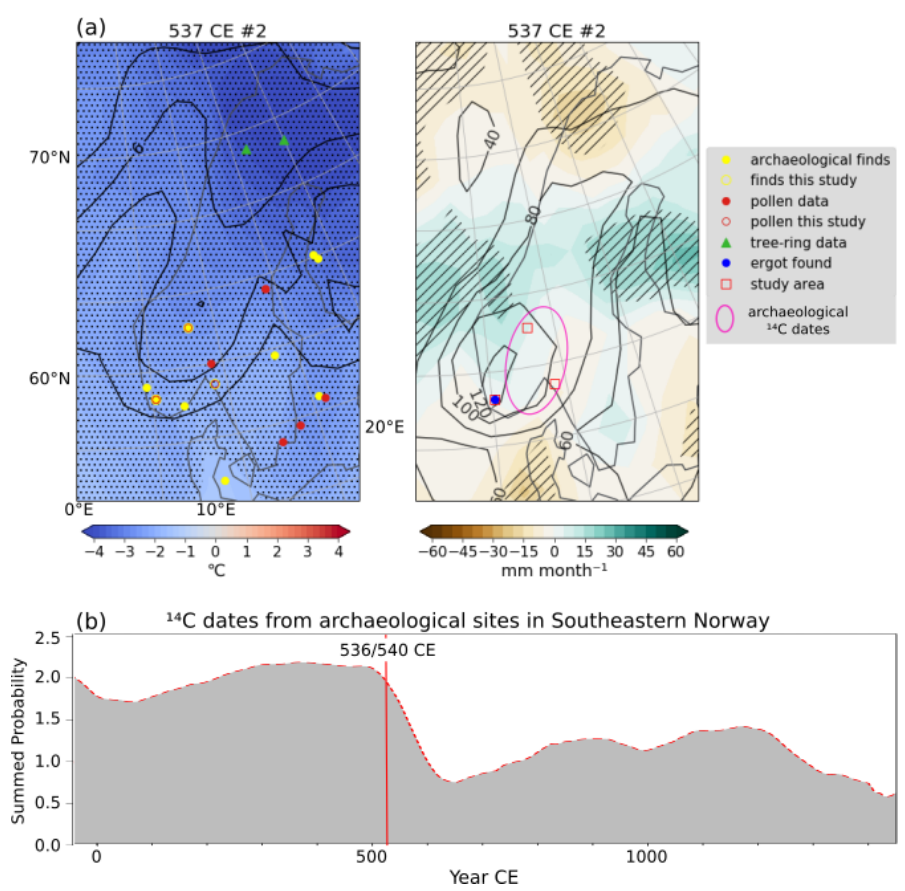
Figure 9. Synthesis figure. (a) Temperature and precipitation anomaly maps of Scandinavia from one realization of the MPI-ESM model (ensemble member no. 2), with markers for archeological, historical, and pollen proxy data supporting this model simulation. Pollen data showing reduction in agriculture in the mid-500s, archeological finds indicating abandonment, and tree-ring reconstructions showing a 3.5 ◦ C cooling in northern Scandinavia 1–2 years after the 536CE eruption. The data used for this figure are listed in Table A4. (b) Summed probability distribution of 4012 14 C dates (Loftsgarden and Solheim, 2022) from archeological sites in southeastern